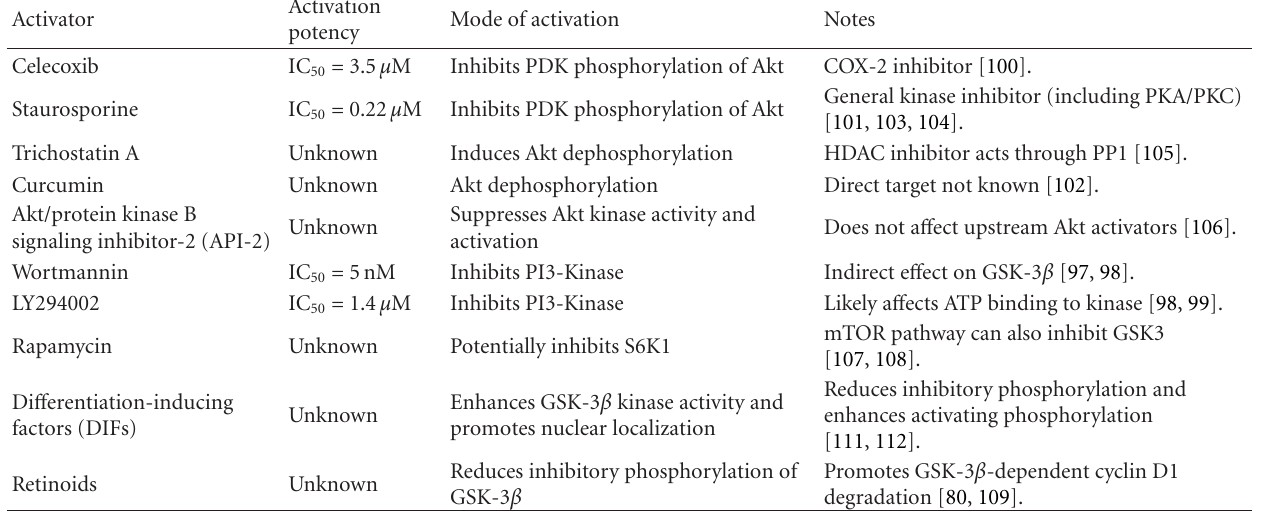
Table 3: List of known positive regulators of GSK-3 β .